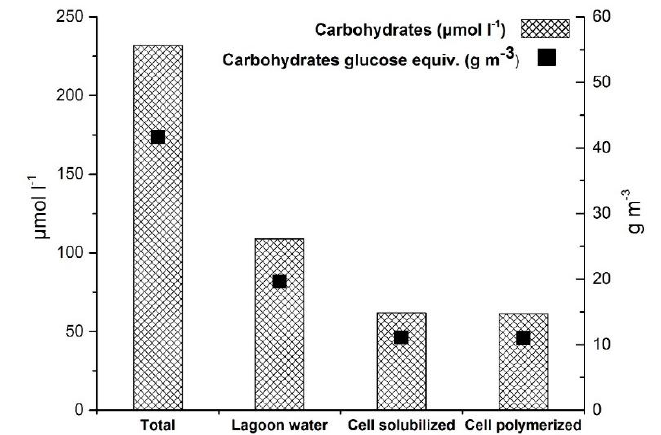
Figure 4. Mean values (n = 2; three repetition of analysis in each sample) of content of carbohydrates free dissolved in lagoon water, solubilized in cells and polymerized in cell structures, measured as glucose analogs.